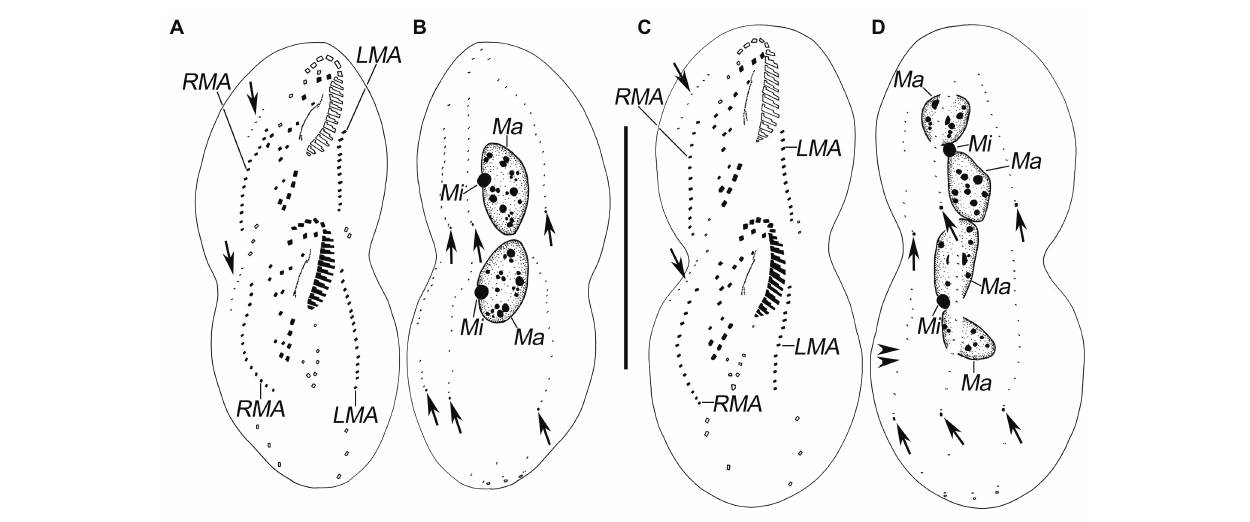
FIGURE 4 | Late stages of morphogenesis in Quadristicha subtropica n. sp. after protargol staining. (A,B) Ventral and dorsal view of a late divider, to show the dorsomarginal kineties anlagen (arrows in A ) and the caudal cirri (arrows in B ). (C,D) Ventral and dorsal view of a very late divider to demonstrate the dorsomarginal kineties (arrows in C ) and caudal cirri (arrows in D ). Arrowheads in D show the gap in dorsal kinety 1. Bar: 70 μ